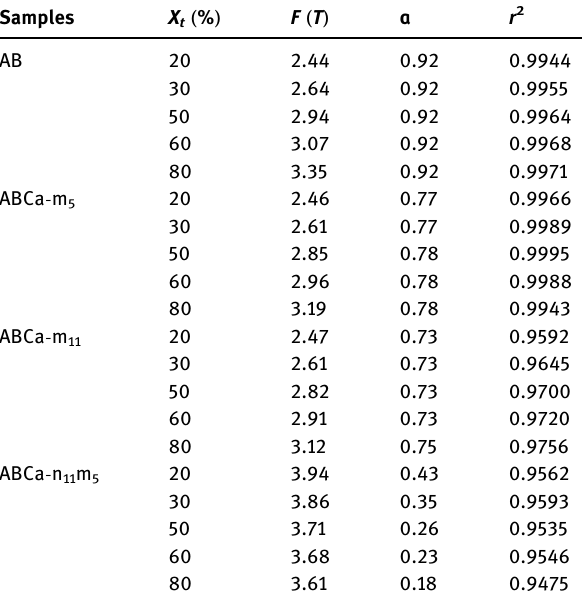
Table 8: Mo ’ s parameters for the crystallization of AB, ABCa - m 5